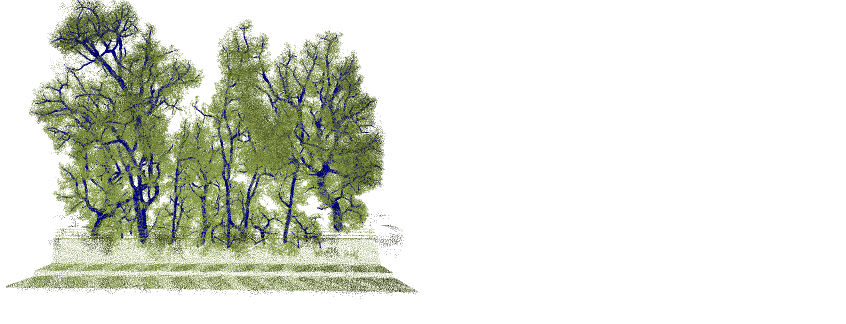
Figure 1. A reconstruction of a challenging, cluttered environment where all tree bases are occluded and approximately 2 m below the overpass. It shows the overlaid view of point cloud (green) and generated trees